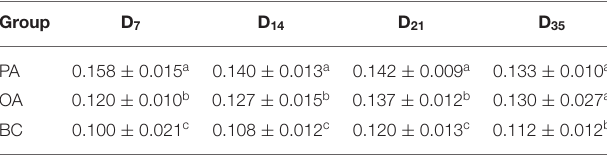
TABLE 2 | Changes in lymphocyte proliferation of blood (A570 value).